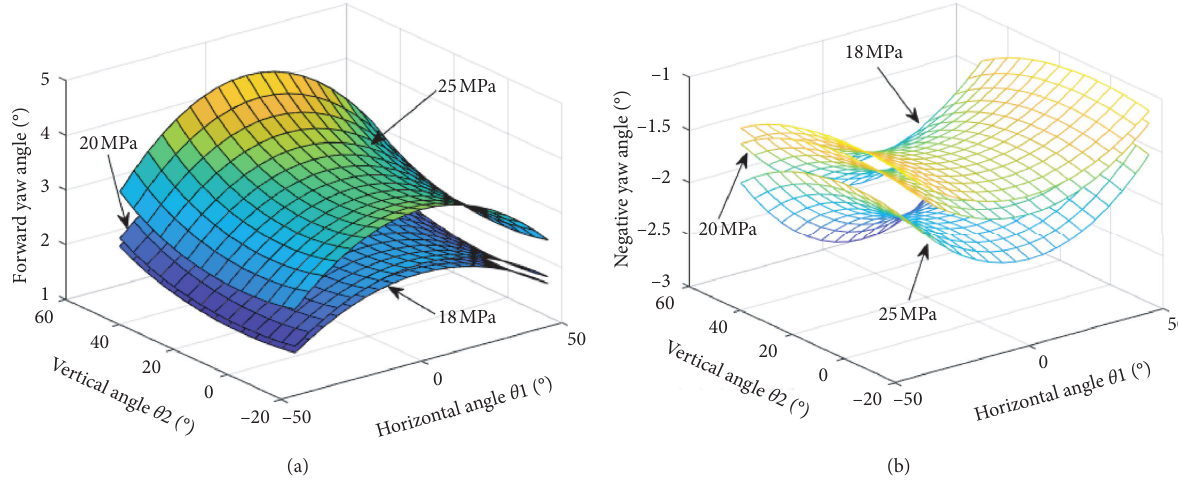
Figure 5: Vertical vibration swing angle of cutting part. (a) Forward swing angle. (b) Negative swing angle. part (vertical lifting angle θ ), the movement of the tele- 2 scopic part ( d ), and the movement of the roadheader fu- selage relative to the roadway (cutting feed d ). The 0 movements of each mechanism belong to series. The ki- nematics analysis of the cutting head of the roadheader is carried out by using the Dmurh method in robotics [15, 16]. According to the Dmurh method, the displacement of the moving joint and the rotation angle of the rotating joint can be transformed into the coordinates of the cutting head to describe the position and attitude of the cutting head relative Figure 6: Kinematic coordinate system of to the roadheader and roadway. The homogeneous trans- formation matrix for describing the cutting head in the cutting roadway is controlled by the rotation of the turntable roadway coordinate system is (horizontal rotation angle θ ), the rise and fall of the cutting 1